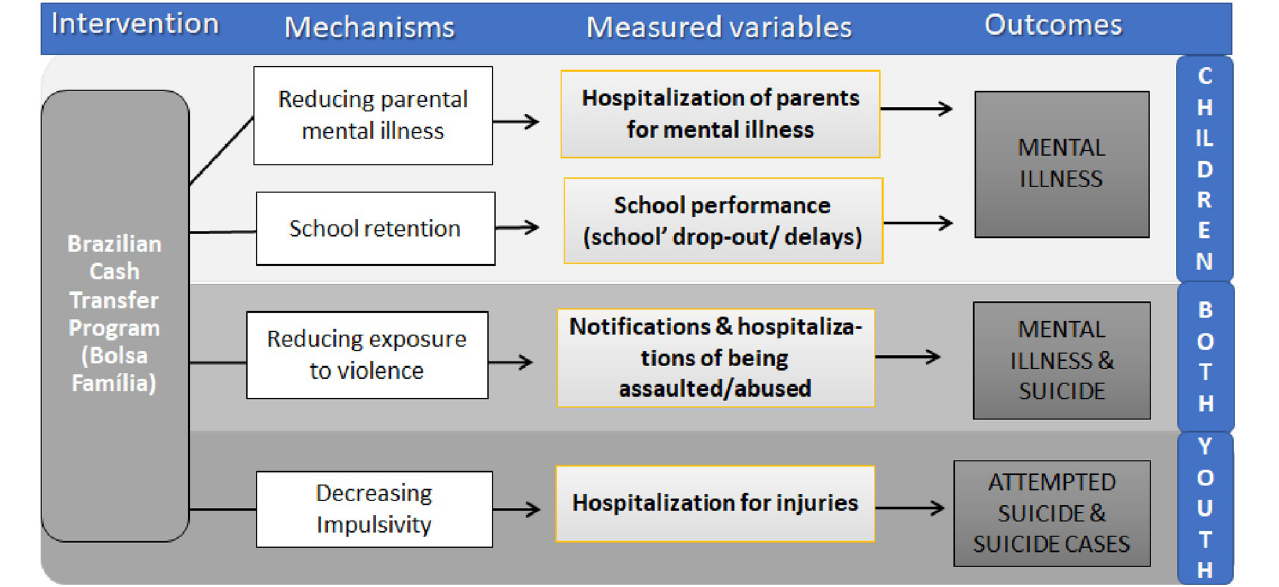
Fig 1. Potential mechanisms and pathways through which Bolsa Familia Program (BFP) may affect mental health-related hospitalizations and suicide among children and youth.